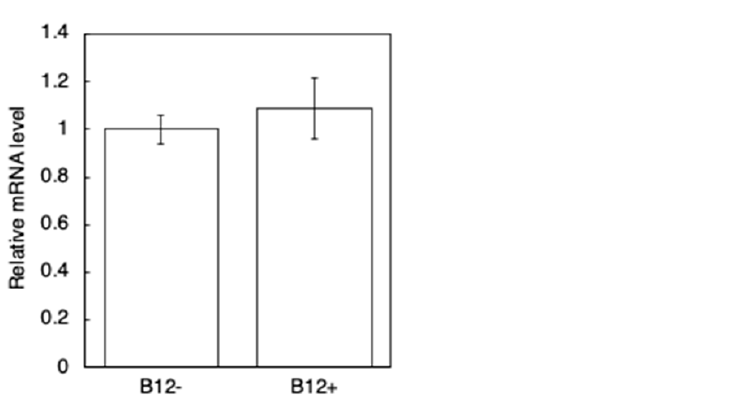
Figure 3. Paralysis rate of B 12 − , B 12+ , and B 12 − +AsA-2G GMC101 worms. Young adult worms were incubated at 25 °C to induce A β production. The mean percentage of unparalyzed worms is plot- ted against the time post temperature shift (h). All values represent the mean ± SD of three inde- pendent experiments (n = 3). Approximately 270 worms were screened for each condition. Aster- isks indicate significant differences compared to the B 12 − worms at same time point (* p < 0.05). To investigate if B 12 supplementation affects the transcription level of A β rather than simply reducing its accumulation in muscle cells, qRT-PCR of the B 12+ and B 12 − GMC101 worms was performed 24 h after inducing A β expression. The results indicated no significant difference in the A β mRNA levels between the B 12+ and B 12 − GMC101 worms (Figure 4). Additionally, immunoblotting indicated no significant difference in the level of the monomeric form and aggregated form of the A β peptide (A β 1–42 ) between the B 12 − and B 12+ GMC101 worms (Figure 5).